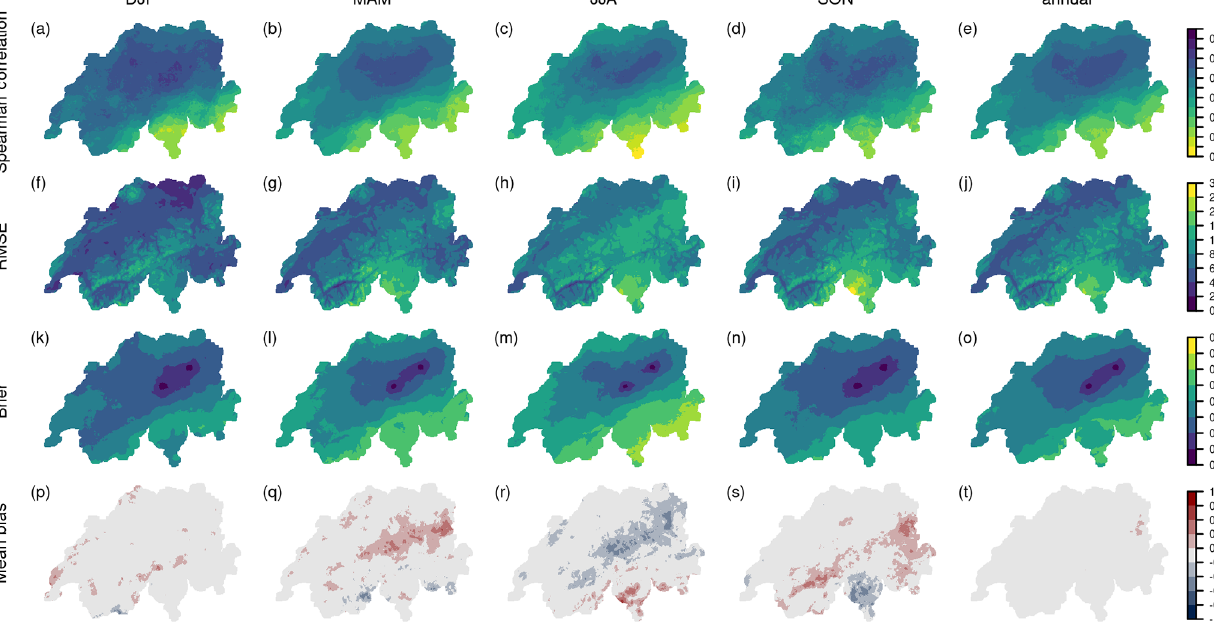
Figure 6. Cross-validation results of a network of 31 stations as in Fig. 1c for precipitation during 1961–2020 for the four seasons (DJF, MAM, JJA, SON) and annually. (a–e) Spearman correlation, (f–j) RMSE, (k–o) Brier score, (p–t) mean bias. The RhiresD data set also contains the northern catchments in addition to